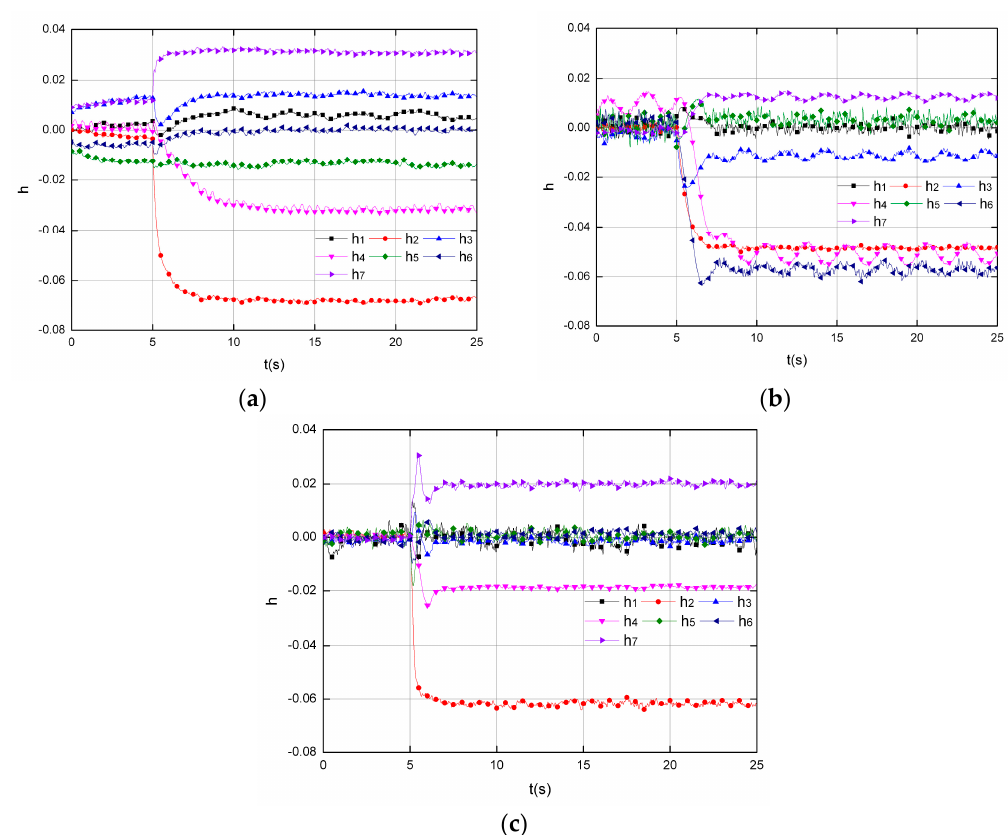
Figure 7. The health estimation corresponding to the injected 6% decrease on h 2 , 2% decrease on h 4 and 2% increase on h 7 ,that is applied at t = 5 s (Mode 5) in scenarios with uncertainties. ( a ) Results by KF; ( b ) Results by SMO; ( c ) Results by SOSMO.